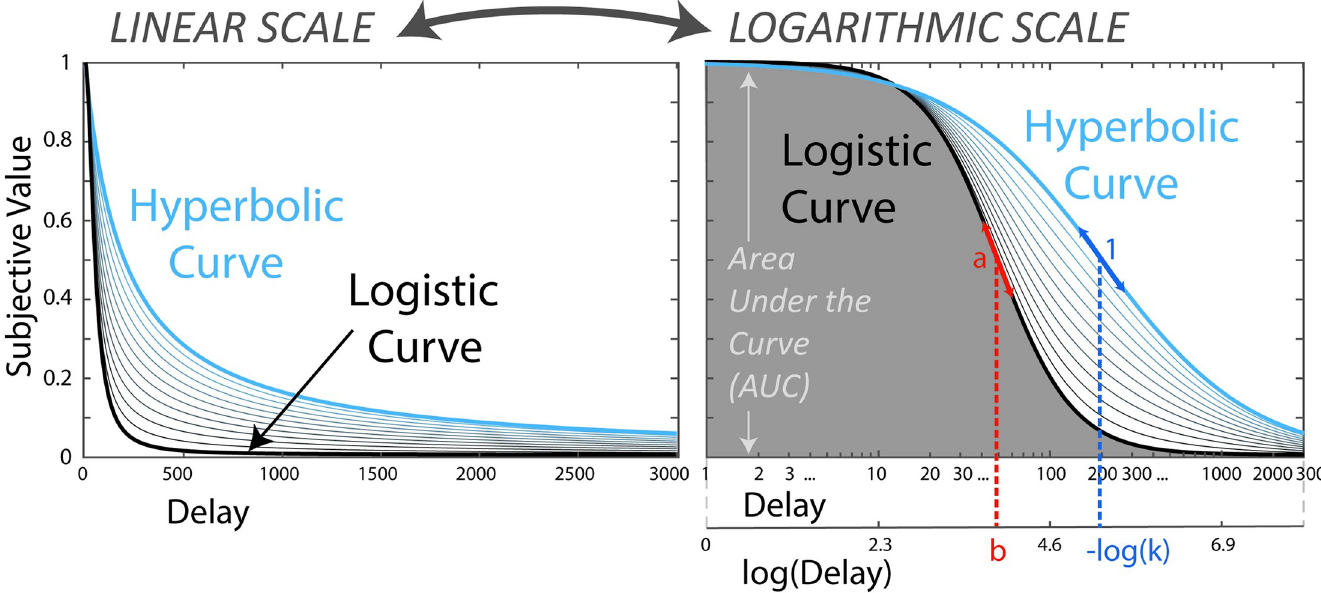
Fig 1. A logistic function framework to model indifference points data. Illustration of the transformation from a linear scale to a logarithmic scale of the classic hyperbolic curve; and illustration of the transformation from a logarithmic scale to a linear scale of a logistic function curve. The logistic curve is characterized by parameters a (the slope at the inflection point) and b (the log-delay at the inflection point). The hyperbolic curve is a particular type of logistic function with parameters a = 1 and b = − log k , where k is the classic discounting